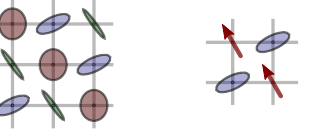
Figure 4: Different types of product ground states in semi-ordered phase ( π/ 4 ≤ θ ≤ π/ 2). Left: three-sublattice order with neighboring directors being perpendicular (antiferro- quadrupolar ’AFQ3’ state—discs with differing colors are quadrupolar states viewed at dif- ferent angles); right: two-sublattice order with directors aligning parallel to neighboring mag- netic moments (half nematic half magnetic ’ m = 1 / 2’ state). Note that the color coding is only meant to highlight which particles are in the same quantum